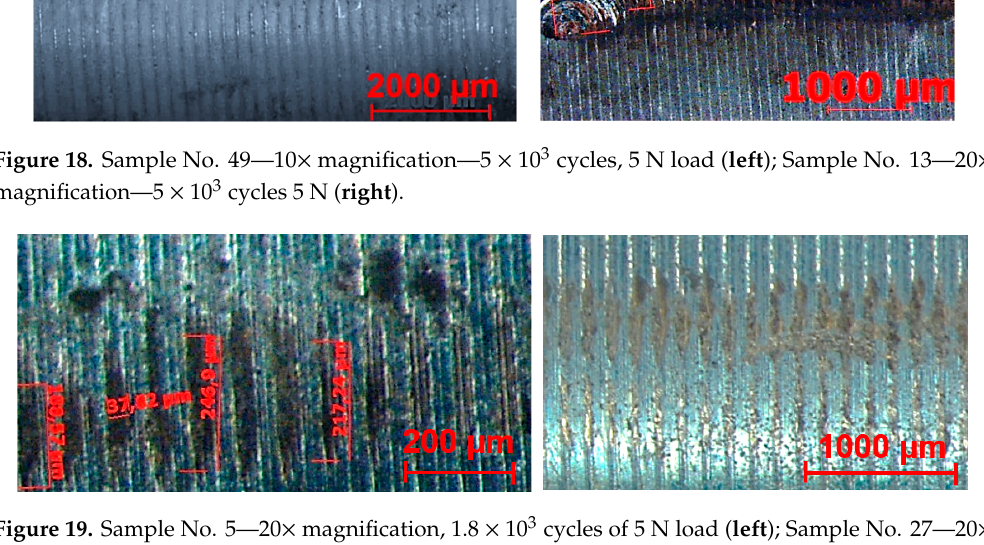
Figure 19. Sample No. 5—20 × magnification, 1.8 × 10 3 cycles of 5 N load ( left ); Sample No. 27—20 × magnification, 20 × 10 3 cycles, 5 N load ( right ).